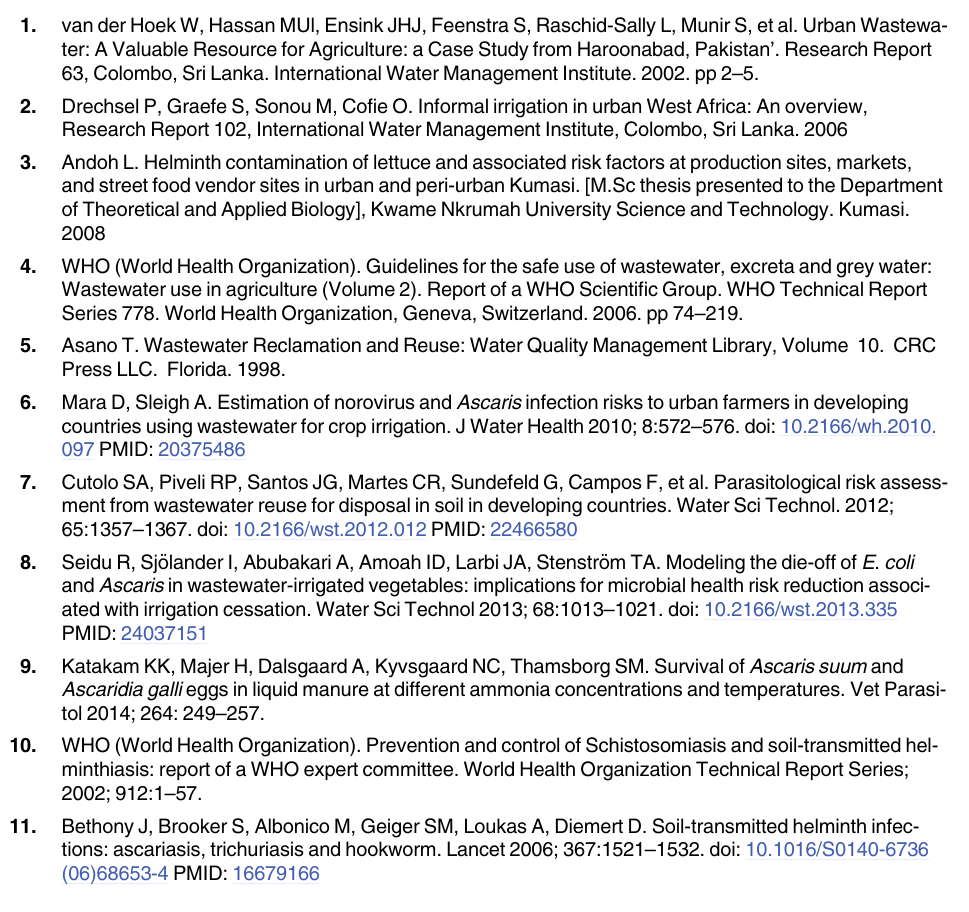
S1 Data Tables. Tables containing the raw data recorded for each sample of irrigation water, soil and